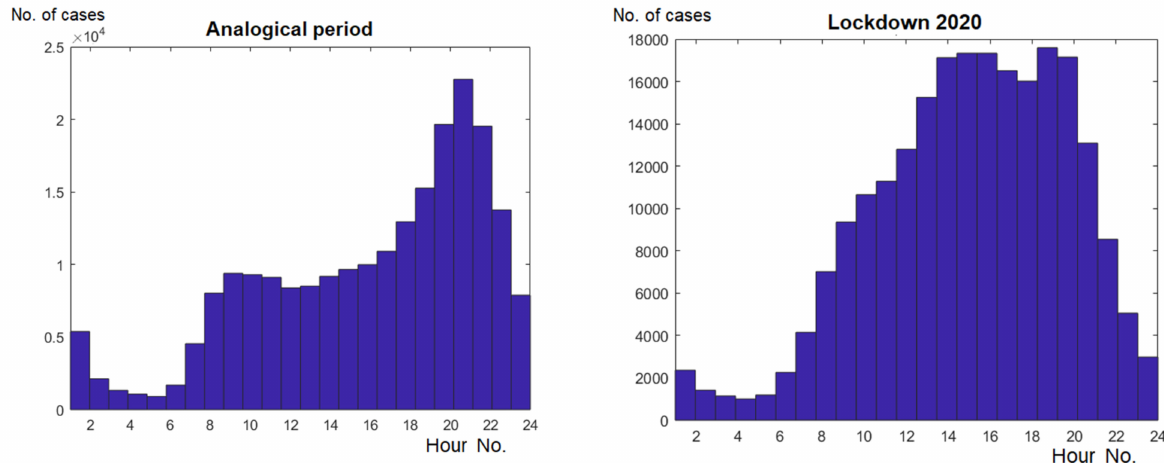
Figure 8. Histograms of peak load hour of apparent power during the lockdown and the analogous period in 2018.